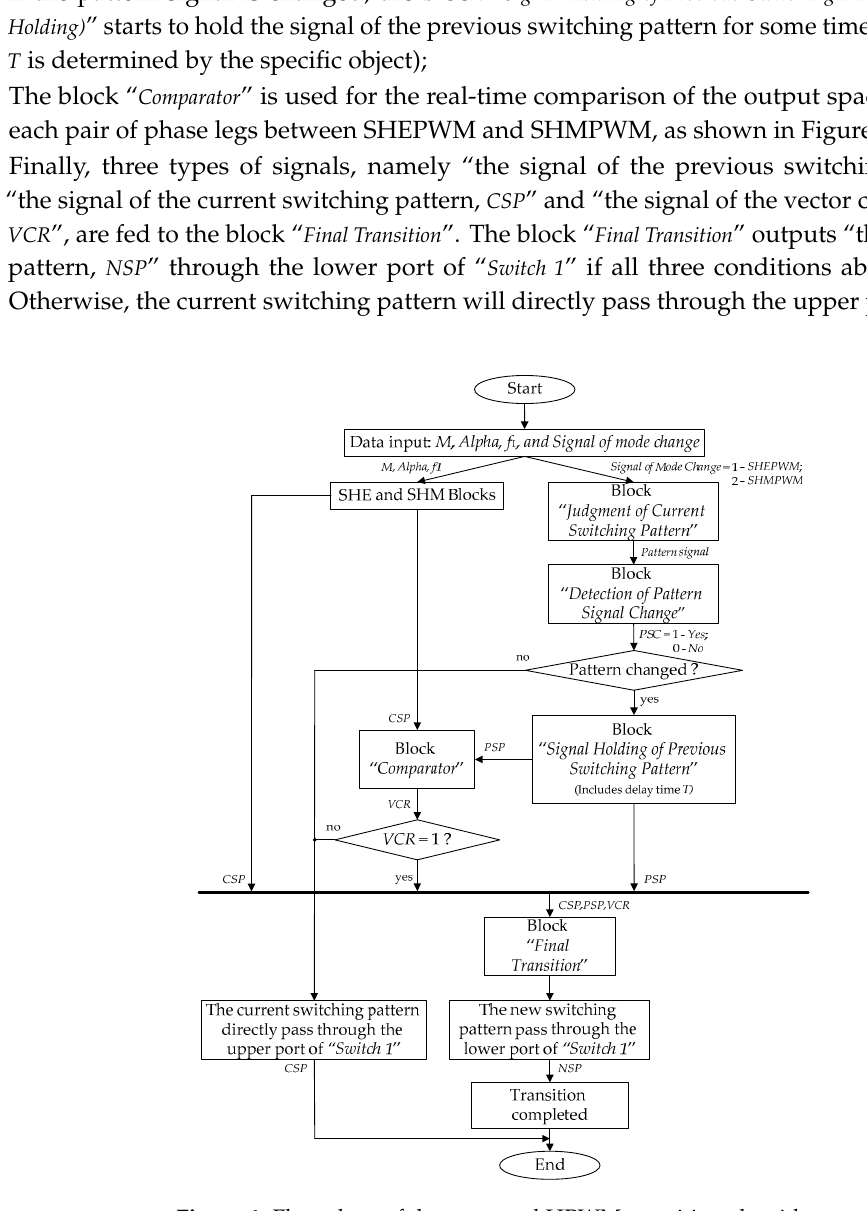
Figure 4. Flow chart of the proposed HPWM transition algorithm.